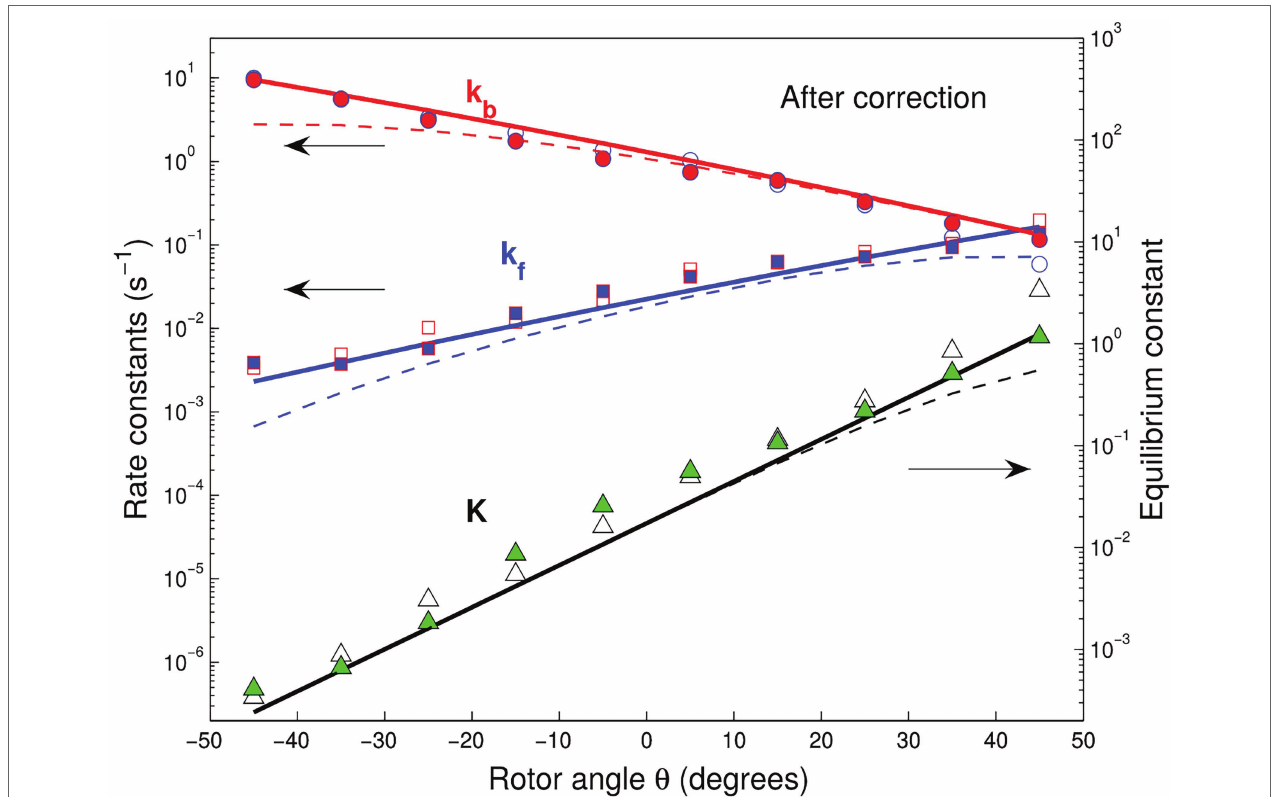
FIGURE 3 | Binding (forward) and release (back) rate and equilibrium rate constants vs. θ angle for Cy3-ATP in the presence (solid squares, circles, and triangles) and absence of Pi (open symbols) in solution. The experimental data of Adachi et al. corrected for missed events are compared with their theoretically predicted counterparts (solid lines). Dashed lines show the data without corrections. The figure is reproduced from Volkán-Kacsó and Marcus